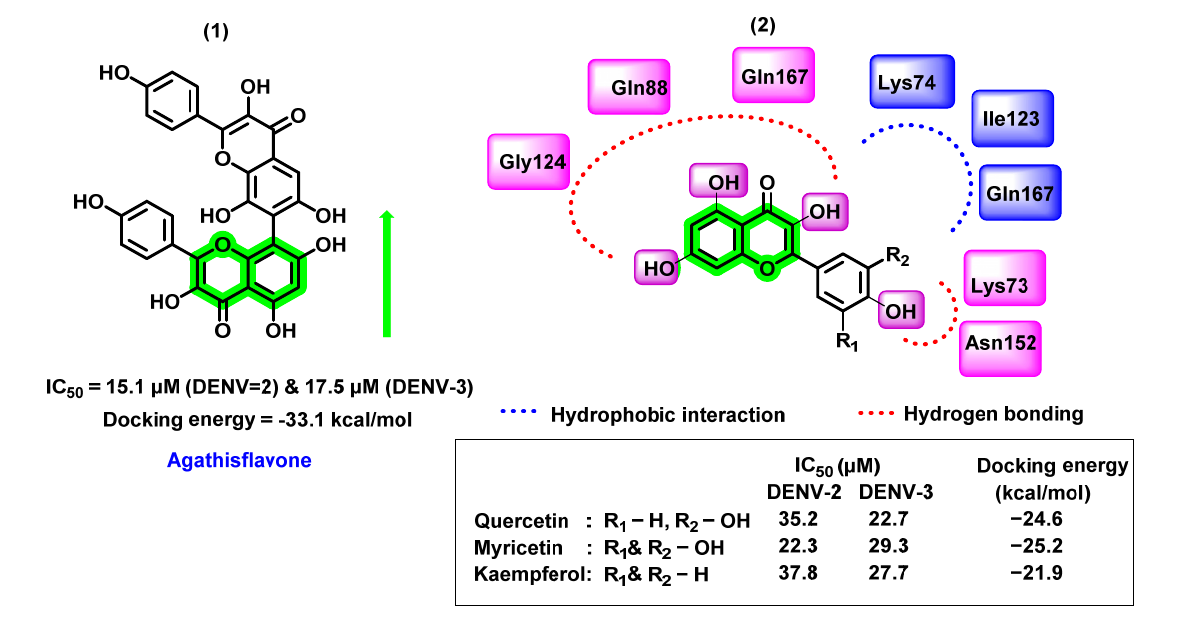
Figure 7. ( 1 ) Non-competitive NS2B-NS3 protease inhibitor ( 2 ) chromene derivatives complex with the allosteric binding site of NS2B-NS3 protease showing hydrogen bonding and hydrophobic in- teractions.